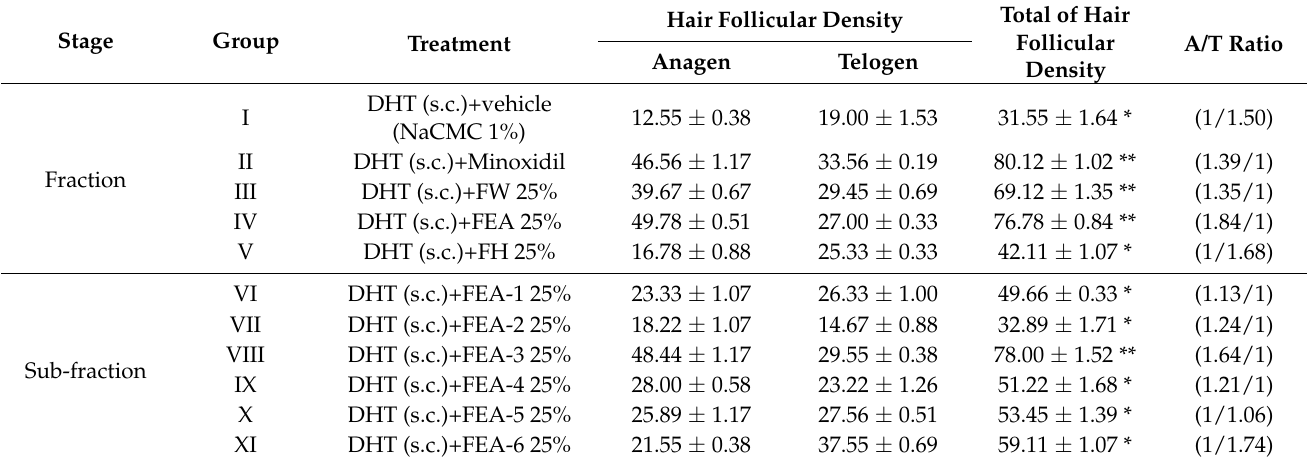
Figure 3. Photomicrograph comparison of hair follicles for each group; ( I ) DHT+vehicle, ( II ) DHT+Minoxidil, ( III ) DHT+FW 25%, ( IV ) DHT+FEA 25%, ( V ) DHT+FH 25%, ( VI ) DHT+FEA-1 25%, ( VII ) DHT+FEA-2 25%, ( VIII ) DHT+FEA-3 25%, ( IX ) DHT+FEA-4 25%, ( X ) DHT+FEA-5 25%, ( XI ) DHT+FEA-6 25% (magnification 20×). Table 3. Hair follicular density and A/T ratio of skin section after administration of the samples